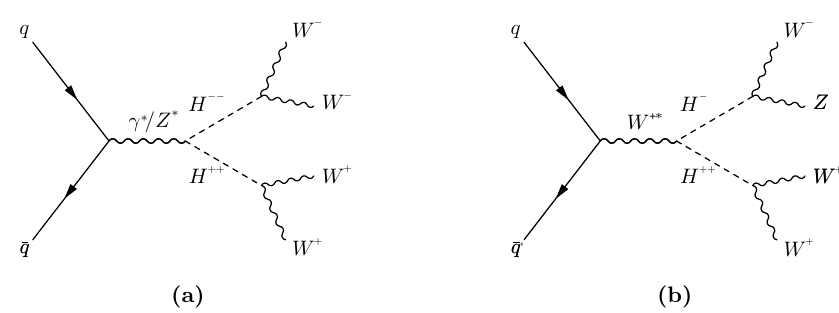
Figure 1 . Feynman diagrams illustrating production and subsequent decay of the H ±± and H ± bosons: (a) H ±± pair production and (b) H ±± and H ± associated production.